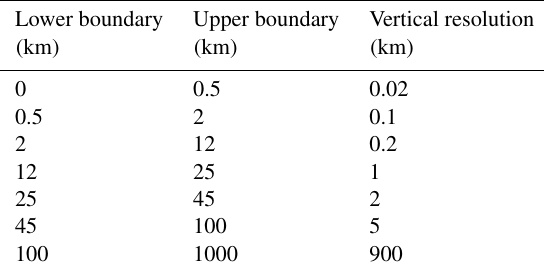
Table A1. Vertical resolution used in radiative transfer simulations for different altitude ranges.